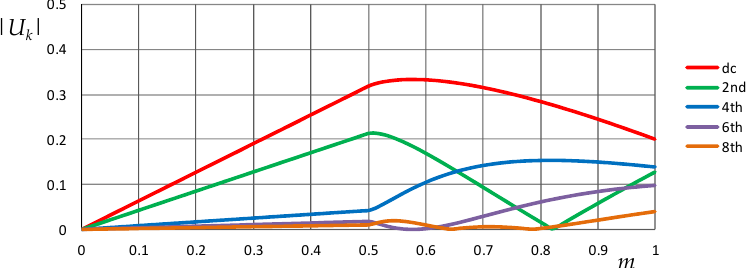
Figure 4. Normalized amplitudes of low-order LDN output voltage harmonics as a function of the modulation index.